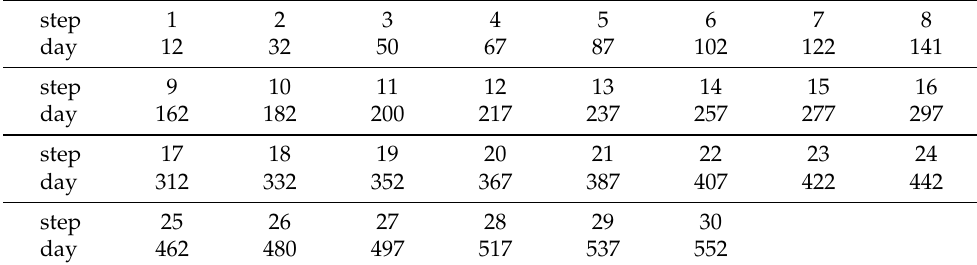
Table 1. The days on which data is assimilated.